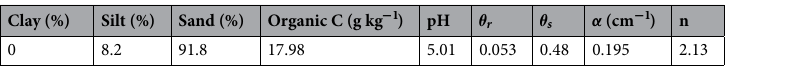
Table 1. Soil properties and optimized van Genuchten parameters. θ r is the residual water content, θ s is the saturated water content, α is the air entry parameter, n is a porosity distribution